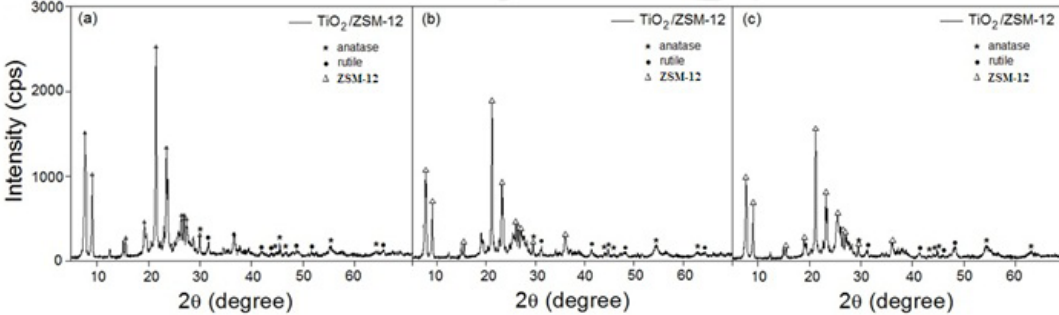
Fig.2. X-ray diffractogram of the calcined TiO